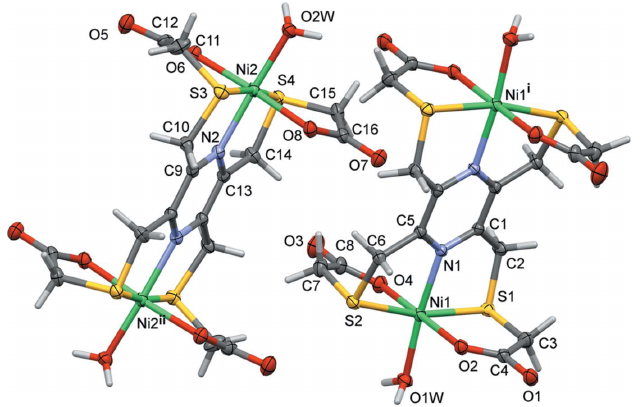
Figure 1 The molecular structure of the two independent molecules of complex I , with the atom labelling. Displacement ellipsoids are drawn at the 50% probability level [symmetry codes: (i) (cid:4) x + 1, (cid:4) y + 1, (cid:4) z + 1; (ii) (cid:4) x , (cid:4) y + 1, (cid:4) z ].